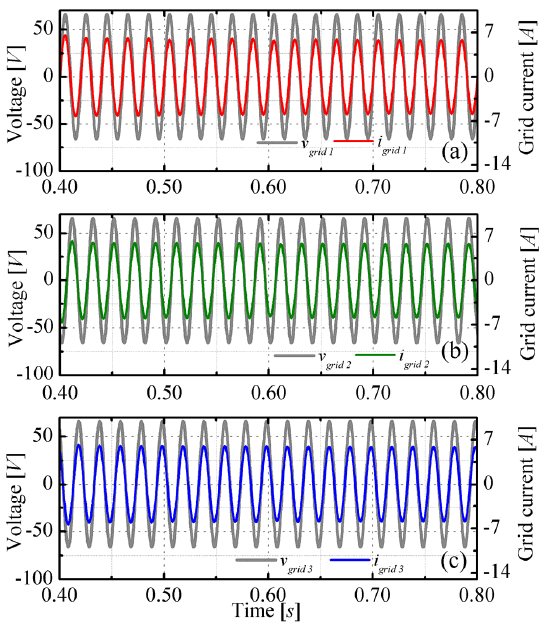
Figure 12. Dynamic partial shading: time behavior of the output currents compared to grid voltages related to ( a ) phase 1; ( b ) phase 2; and ( c ) phase 3.